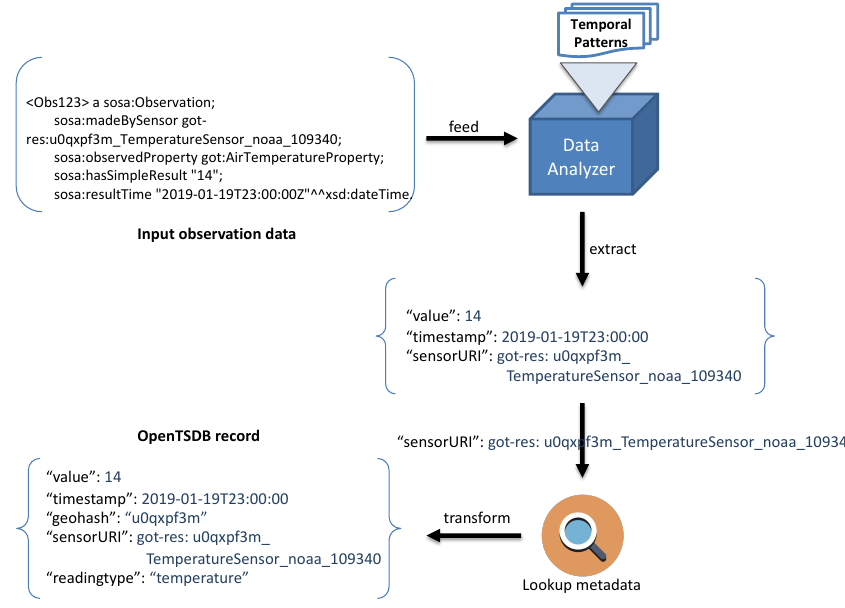
Figure 10. An example of temporal information extraction